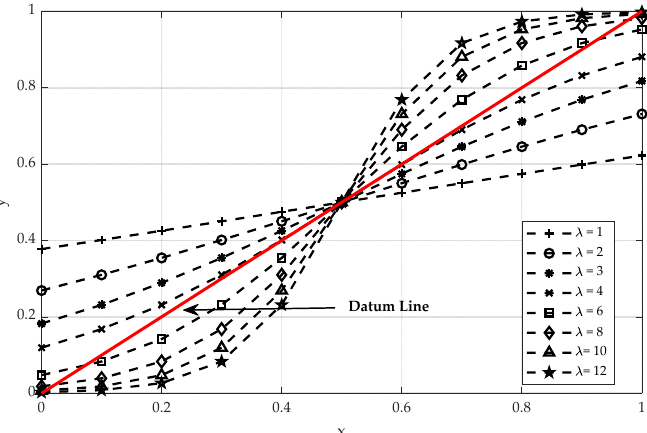
ff erent λ in the interval from 0 to 1.